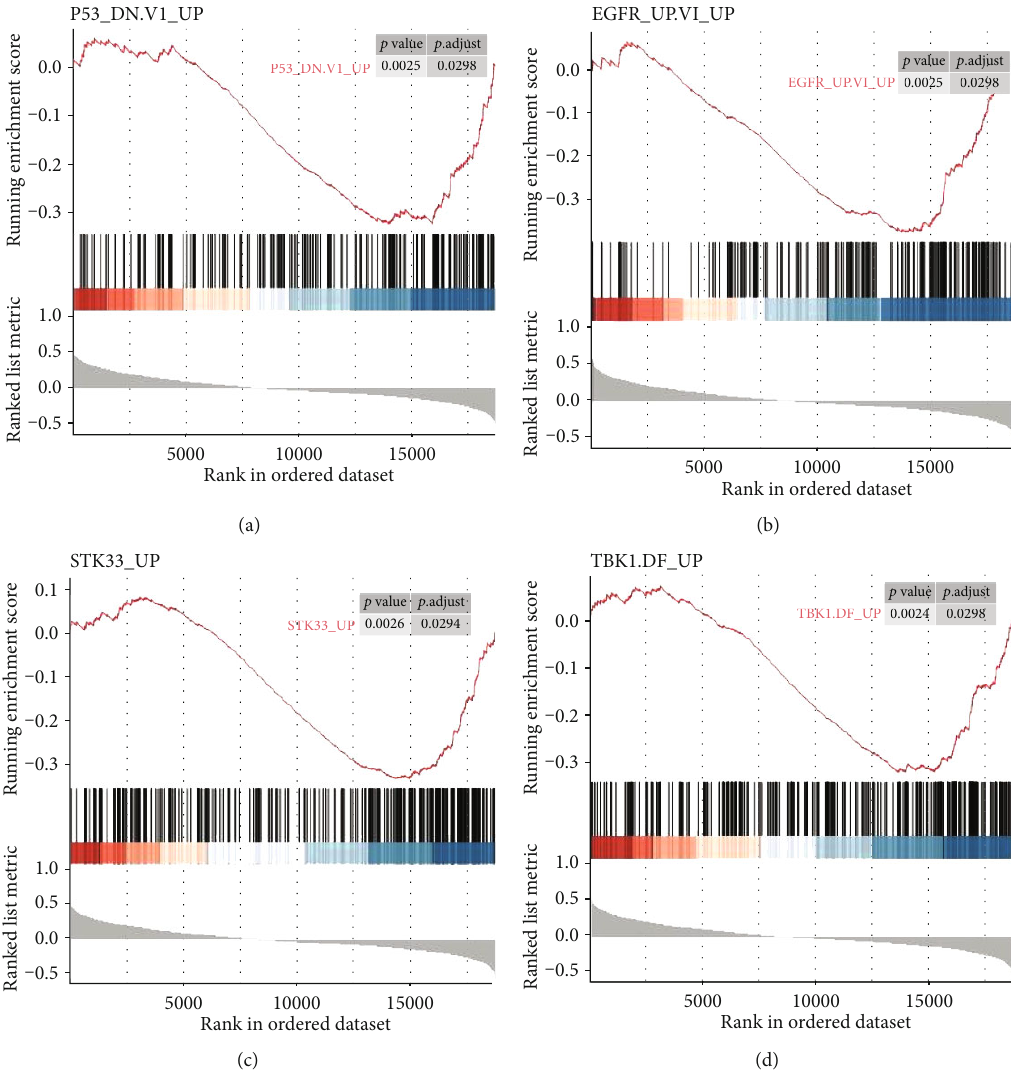
Figure 3: GSEA analysis of TLX1NB in the TCGA LGG dataset. Oncogenic gene sets (C6) were used as the input dataset, and a p value < 0.05 was selected as the signi fi cance threshold. P53 (a), EGFR (b), STK33 (c), and TBK1 (d) gene sets were